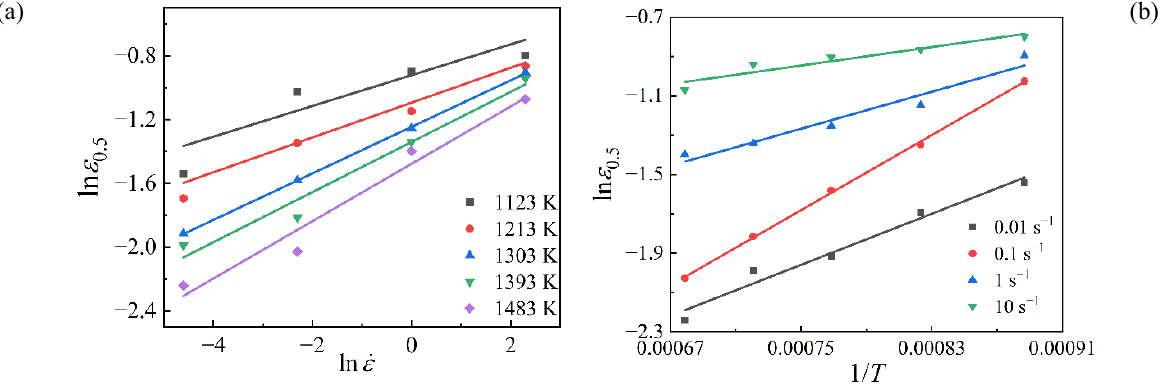
. ε and ln ε 0.5 ~1/ T were fitted linearly as Figure 10. Then, The relationships of ln ε 0.5 ~ln the material constants m 2 and Q 2 were evaluated as 0.1376 and 23,059.65, respectively. By substituting the calculated results of m 2 and Q 2 into Equation (8), the value of a 2 was calculated as 0.03432.